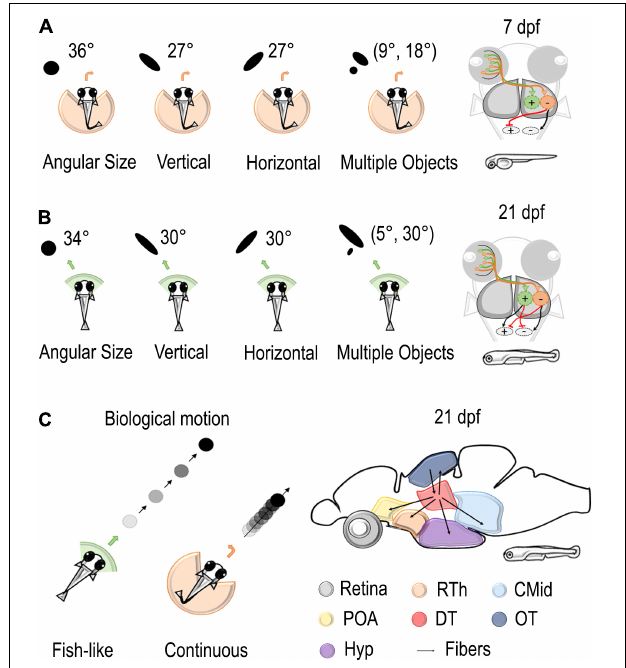
FIGURE 2 | Stimuli and neural circuits involved in social behaviors. (A,B) Left : Several types of stimuli were presented to the visual field of zebrafish using a virtual reality assay. Black dots vary in angular size, vertical dimension, horizontal dimension, and number. At 7 dpf, these stimuli elicited an aversive turn with an increasing probability of repulsion with an increase in the retina occupancy. At 21 dpf, stimuli of the same size were considered attractive. Right : the model proposed by Harpaz et al. (2021) hypothesized the existence of two different populations in downstream areas that are responsible for attraction or avoidance of social stimuli. While only the repulsive population is mature at 7 dpf, the balance of excitation and inhibition of the two populations determines the behavior of the fish at 14–21 dpf. (C) Left : black dots with bout-like motion elicited shoaling behavior in juvenile zebrafish, while continuously moving dots were considered not attractive (Larsch and Baier, 2018). Right : Connectivity patterns of dorsal thalamus where Kappel et al. (2021) found a cluster of neurons selective for bout swim. Rth, rostral thalamus; POA, preoptic area; CMid, caudal midbrain; DT, dorsal thalamus; OT, optic tectum; Hyp,